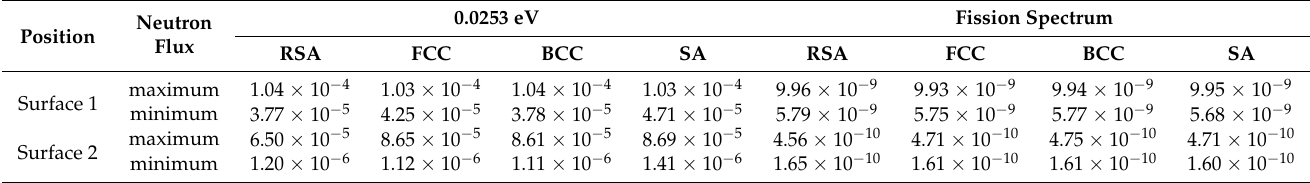
Figure 9. In the case of fission spectrum, the neutron flux distributions at surface 1 and surface 2 under different spatial arrangements. Table 4. The maximum and minimum relative neutron flux of surface 1 and surface 2 under differ- ent